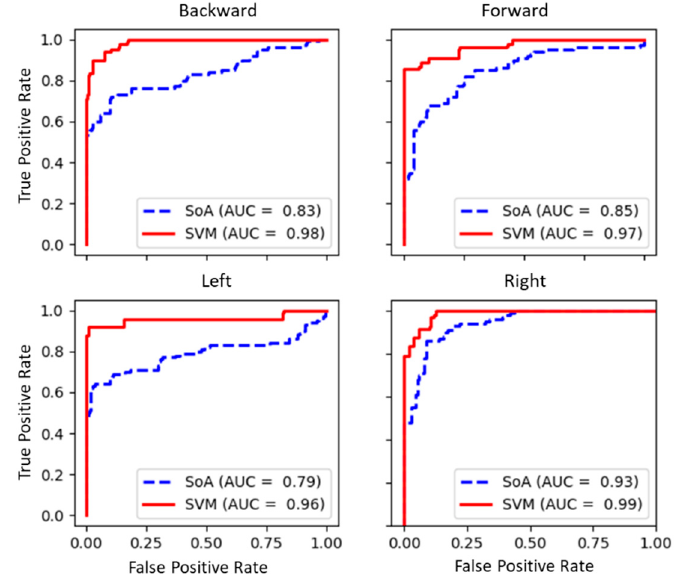
Figure 13. Receiver operating characteristic (ROC) of the SVM method and the SoA method. The SVM model uses 20% data for training at a small volume range (P 2 :15.0 to 25.4 mm 3 ).